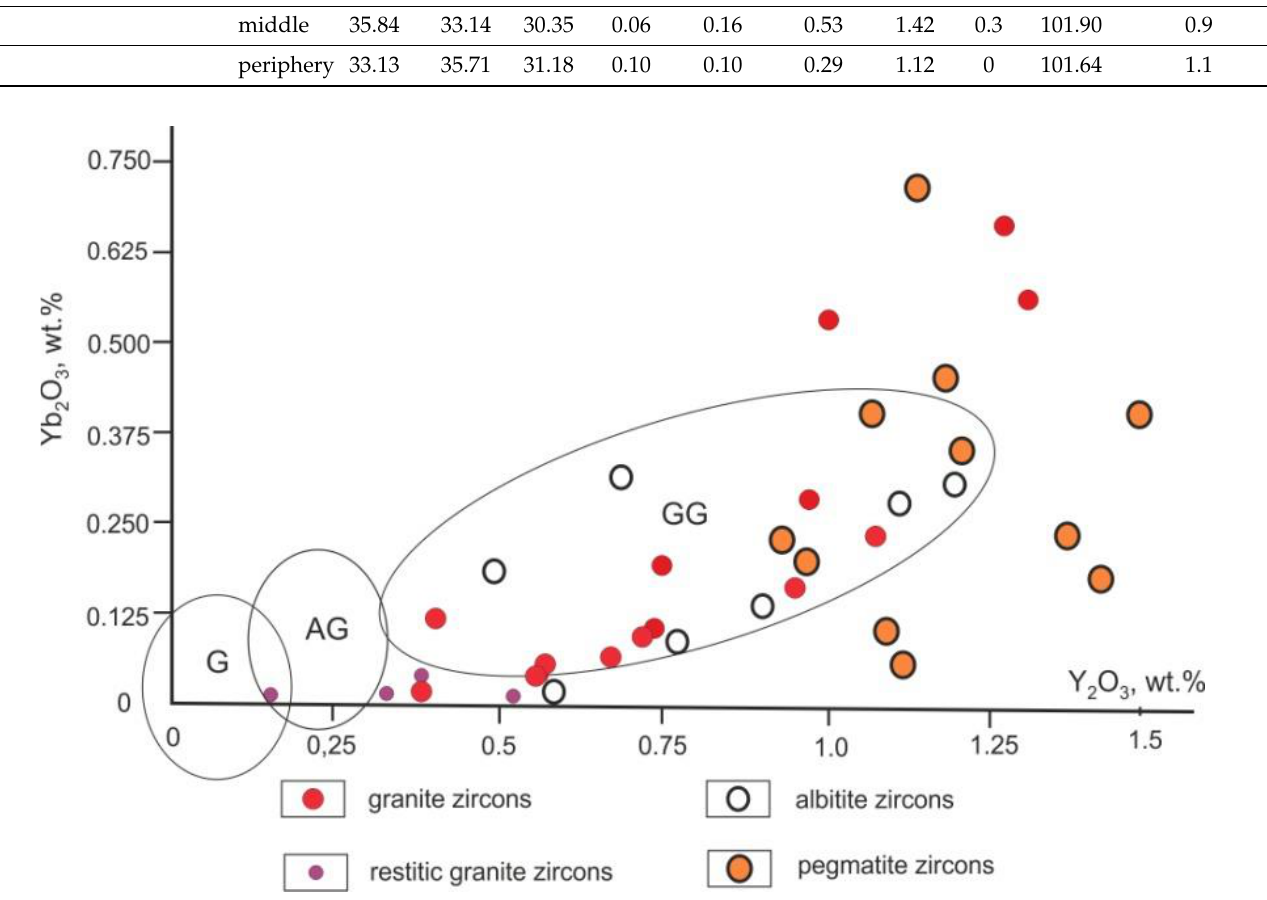
Figure 6. Yb 2 O 3 vs. Y 2 O 3 diagram for zircons from the rocks of the Tommot ore field. Fields in the diagram [44]: G—granite–leucogranite, AG—adamellite–granite, GG—gabbro–granite